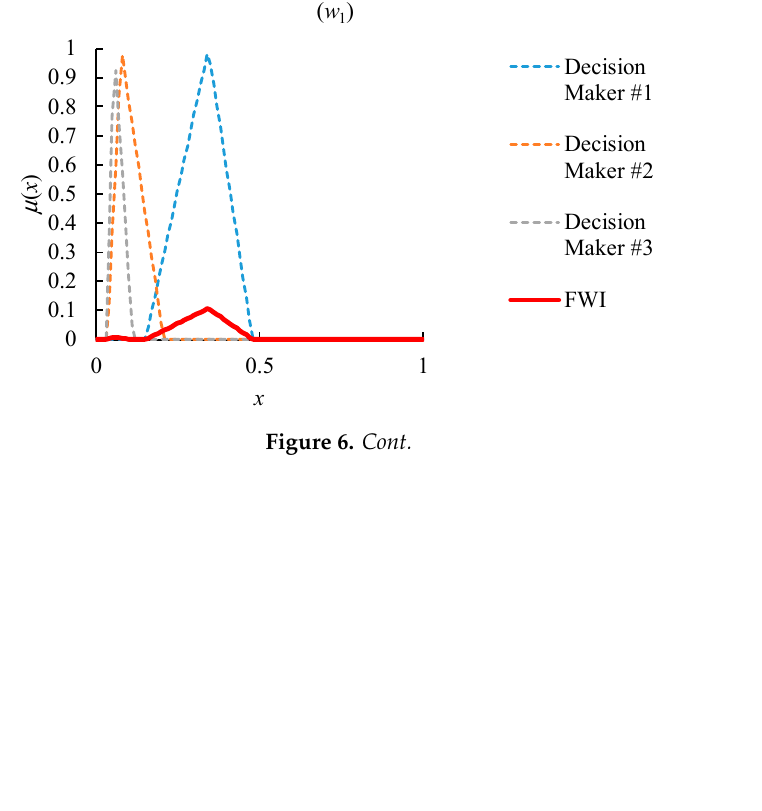
Figure 5. The fuzzy intersection(FI) results of the relative priorities.